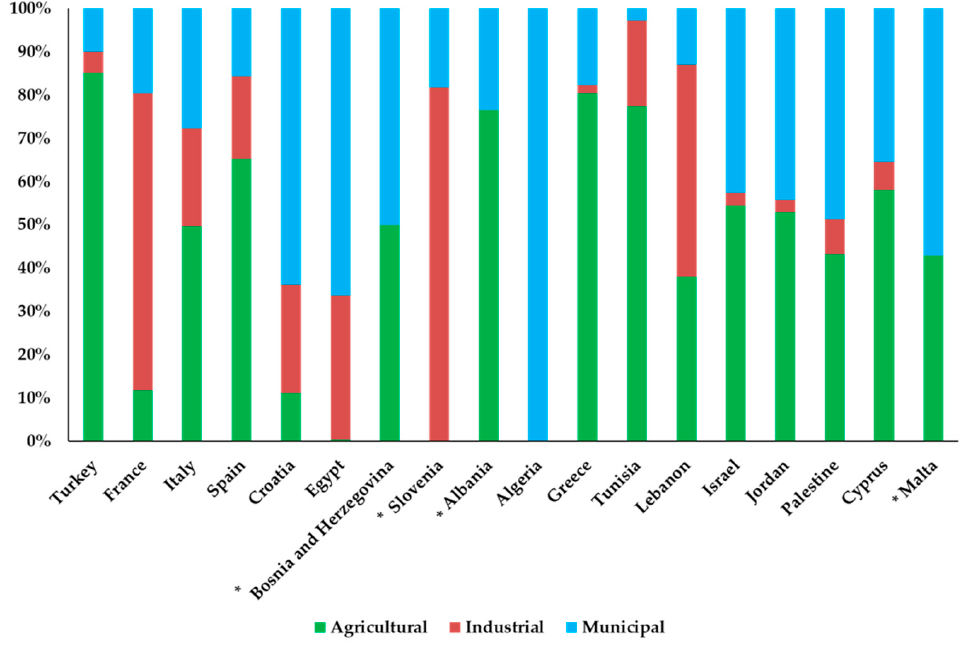
Figure 2. Water use percentages per year for main sectors, 2017 [17]. * Incomplete data .